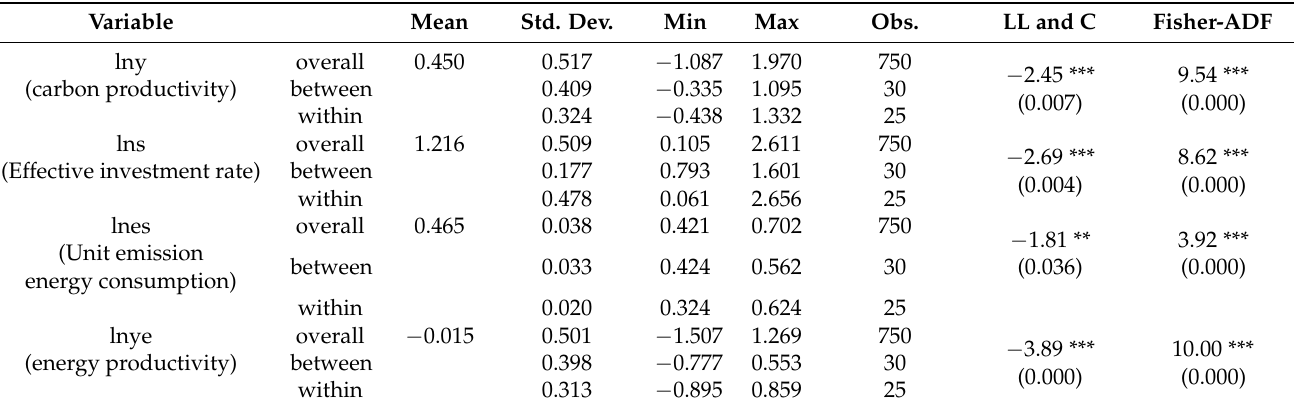
Table 1. Variable Description and Stability Test (1995–2019).